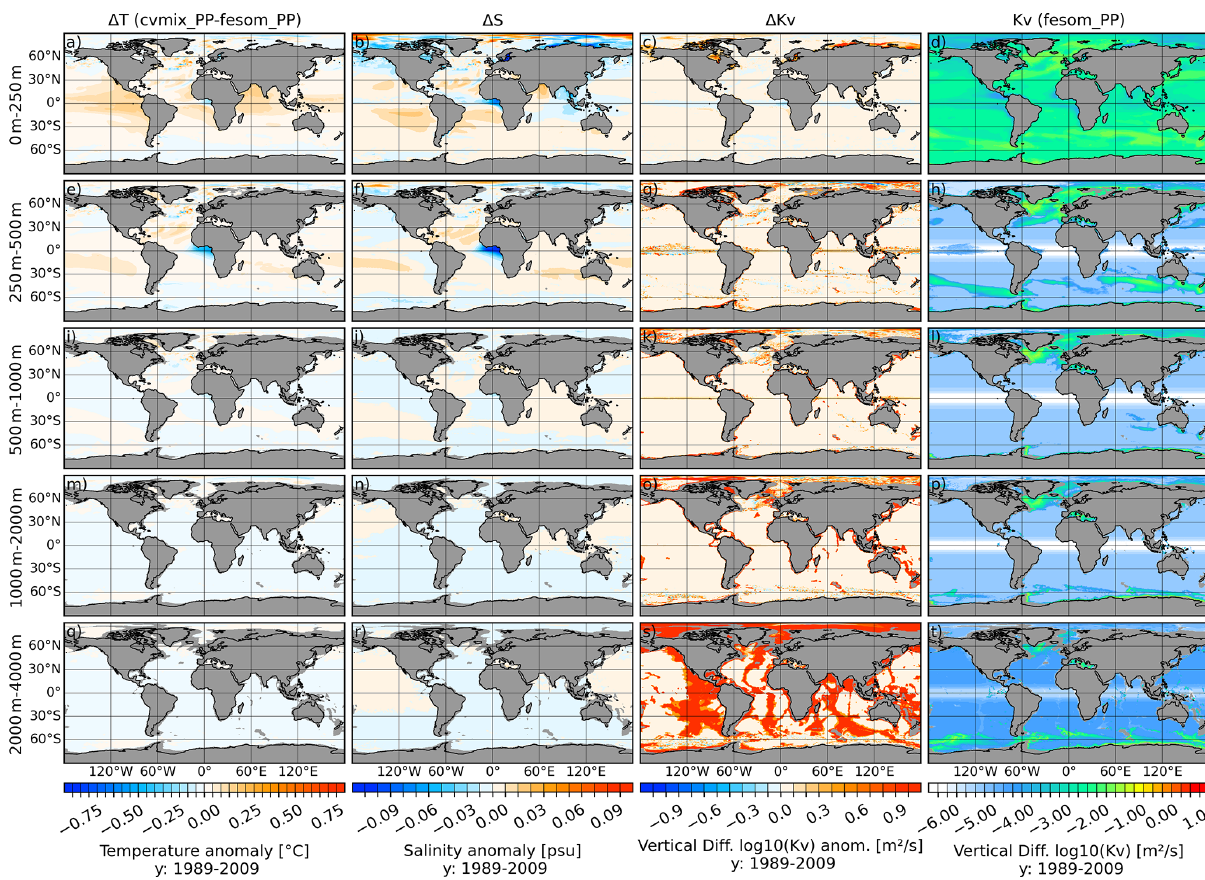
Figure 11. Temperature ( a, e, i, m, q ), salinity ( b, f, j, n, r ) and vertical diffusivity ( c, g, k, o, s ) difference between cvmix_PP and original fesom_PP implementation, as well as the absolute vertical diffusivity values ( d, h, l, p, t ) for fesom_PP averaged for the period 1989 to 2009. The panels show, from top to bottom, the vertically averaged fields for the depth ranges of 0–250, 250–500, 500–1000, 1000–2000 and